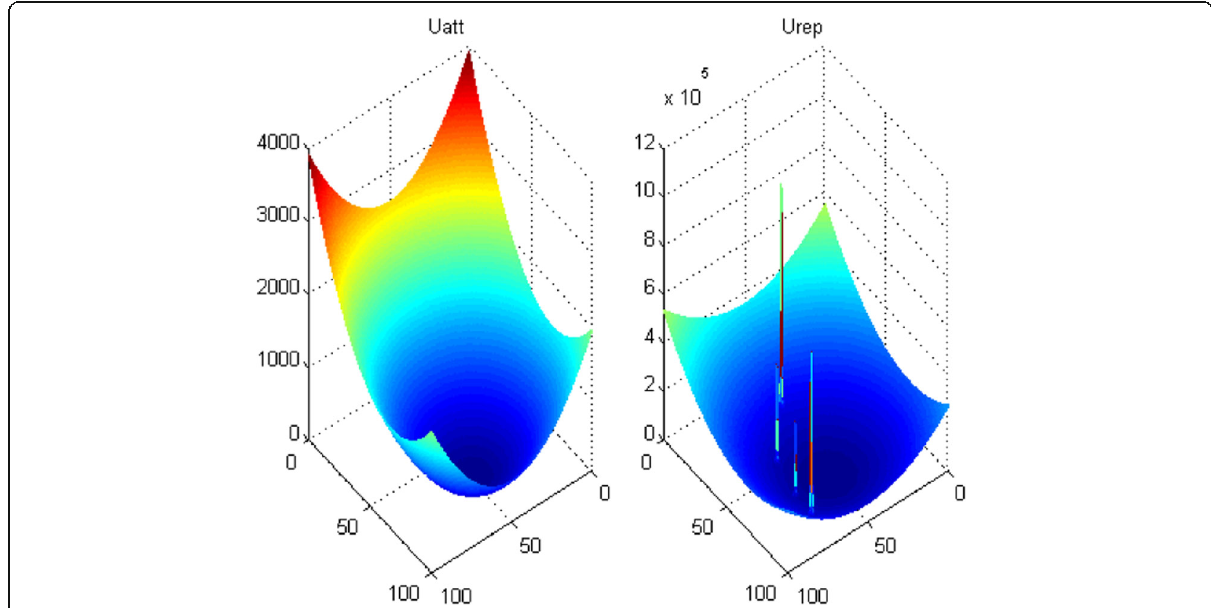
Fig. 19 Mesh plot of the potential energy of attraction and repulsion in the modified artificial potential field algorithm for circular obstacles with radius R = 7